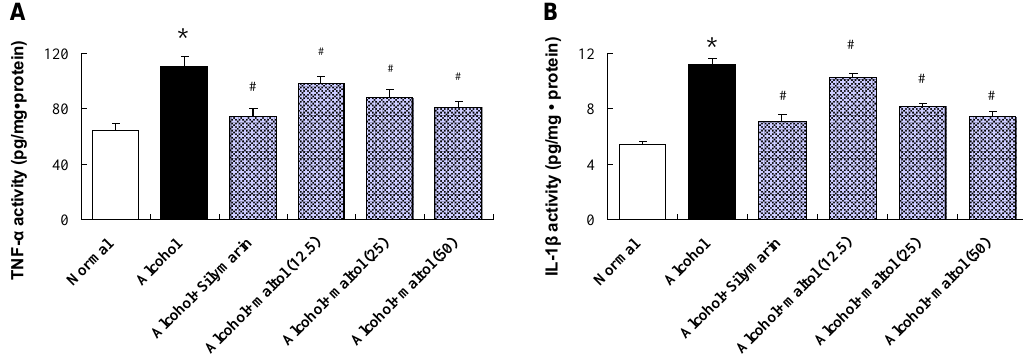
Figure 5. Effects of maltol on liver TNF-α ( A ) and IL-1β ( B ) in alcohol-induced mice. Data represent the mean ± S.D ( n = 8); Significant differences were indicated by * p < 0.05 vs. normal group; # p < 0.05 vs. alcohol group; TNF-α, tumor necrosis factor-α; IL-1β,